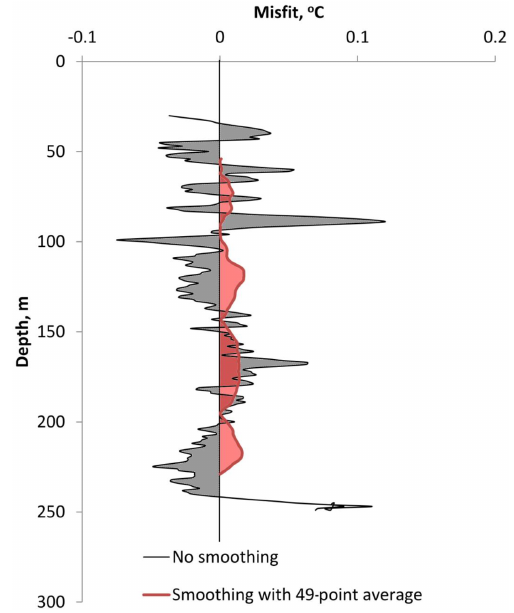
Figure 4. Misfit between measured and modelled temperature pro- files at Beaconsfield. The raw misfit contains substantial high- frequency noise, while the smoothed misfit is much more represen- tative of the low-frequency variations that are more significant for the accuracy of paleotemperature reconstructions. Sumsq misfit and Cumulative area misfit values referred to in the text are effectively the area between the curves and the y -axis of the unsmoothed and 49-point smoothed misfit values